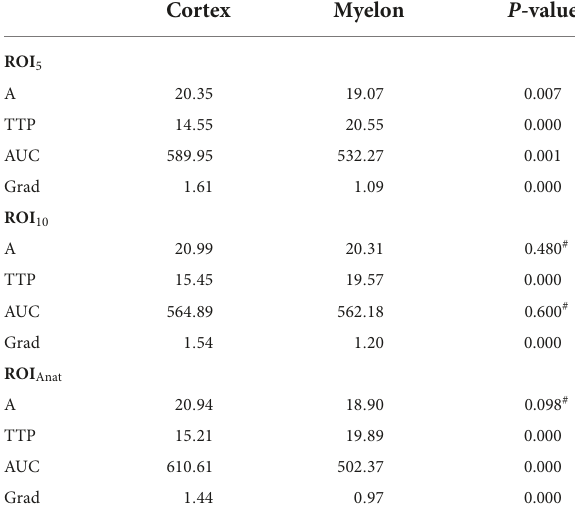
TABLE 4 Differences of TIC parameters between cortex and